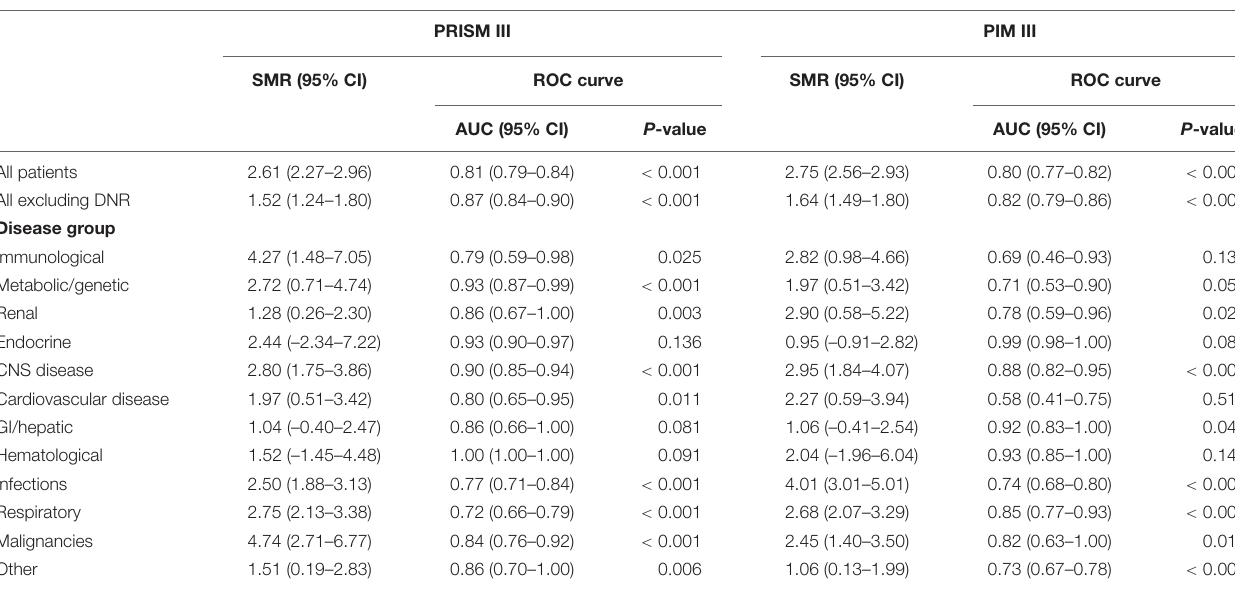
TABLE 6 | Performance per disease category.